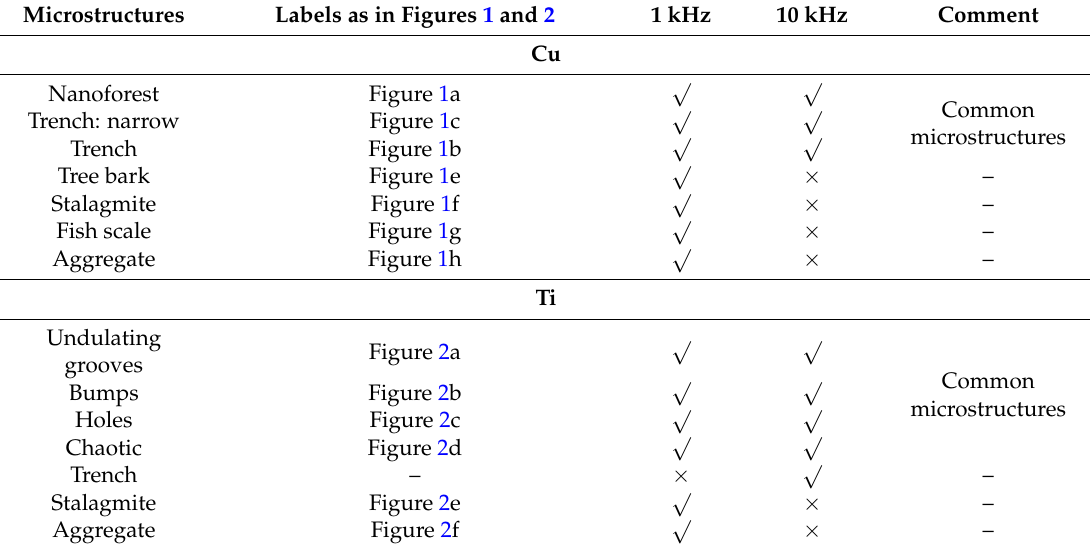
√ × – While the tree bark structures consisted of interwoven long streaks of about 10 µ m diameter running parallel to each other along the horizontal scan direction, the stalagmite structures consisted of saw-tooth like features of about 10 µ m diameter directed towards the vertical scan direction. The fish scale structures were considerably larger than the rest of the microstructures having a diameter of about 25 µ m and seemingly several layers stacked on top of one another. Interestingly, in the case of the aggregate microstructures, some regions were deeper than others (Figure 1h); such behavior was not observed for the rest of the microstructures. At first, this led us to believe that the top surface was just the nanoparticle debris that had partially broken off at the top layer. However, even